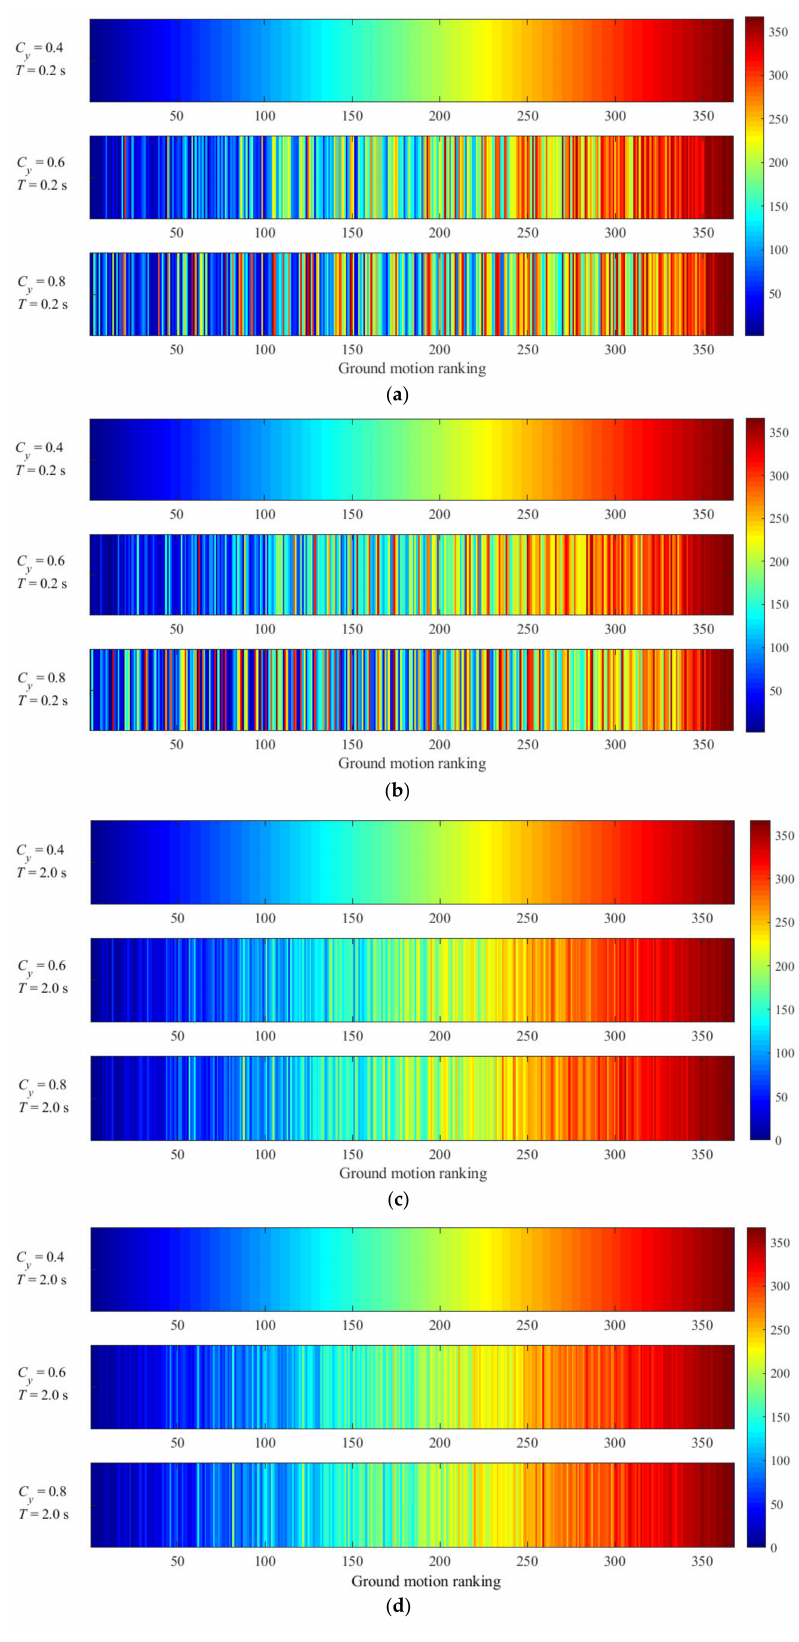
Figure 9. Comparison of displacement response rankings under different C y with a constant T . ( a ) Bilinear model ( T = 0.2 s), ( b ) modified Clough model ( T = 0.2 s), ( c ) bilinear model ( T = 2.0 s), ( d ) modified Clough model ( T = 2.0